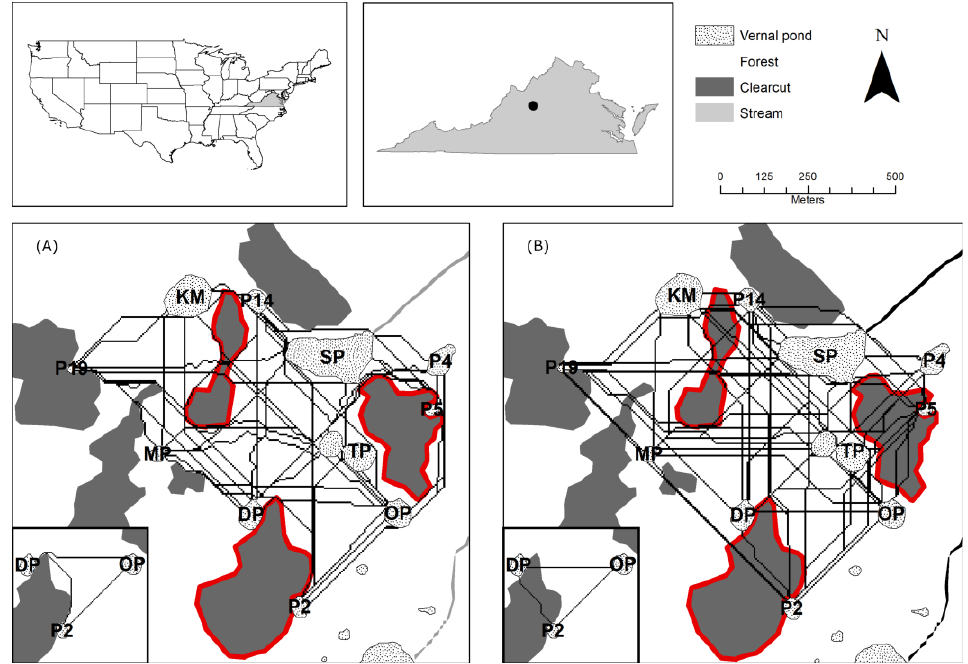
Figure 2. Habitat maps showing dispersal routes between breeding ponds of marbled salamanders ( Ambystoma opacum ) in the Maple Flats Sinkhole Pond Complex calculated using least-cost path analysis. Black lines represent paths, clear-cut areas are dark gray, and ponds are light gray. Ponds labeled in this map include Oak Pond (OP), Deep Pond (DP), Pond Two (P2), Pond 19 (P19), Mystery Pond (MP), Kennedy Mountain Meadows (KM), Spring Pond (SP), Twin Pond (TP), Pond 14 (P14), Pond 5 (P5) and Pond 4 (P4). The red outlines clear-cut areas where there are clear differences between field costs and genetic costs. Dispersal maps were constructed using habitat costs derived from field estimates of migration ( A ) and genetic estimates of migration ( B ).